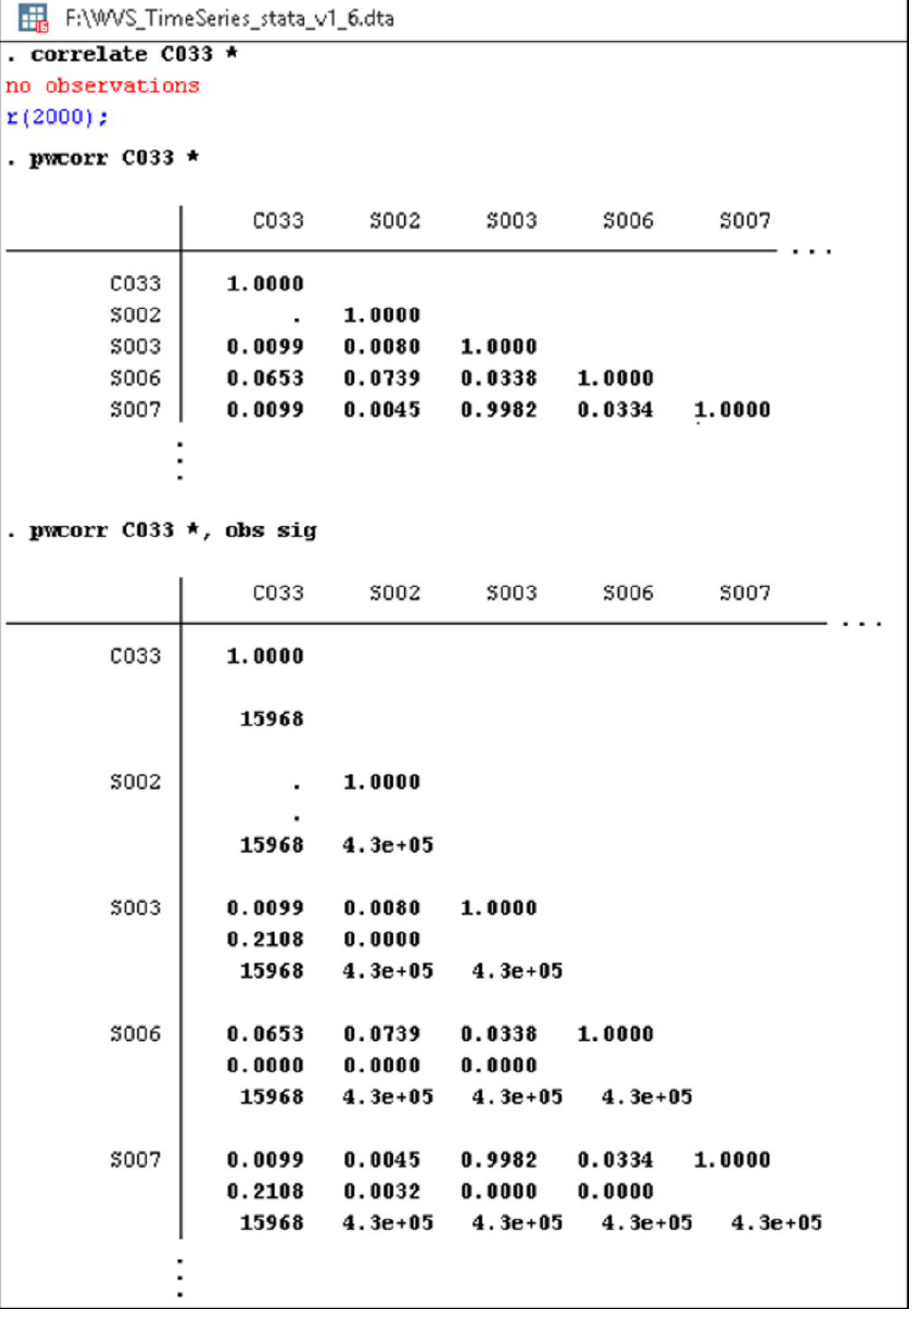
Figure A3. Discovery and filtering limitations when using the correlate and pwcorr commands in Stata. Notes: The same as the first two in Figure 2. The “e” followed by the minus (“ - ”) and a value indicates the E notation corresponding to the scientific one (4.3e+05 is actually 4.3 × 10 5 ).